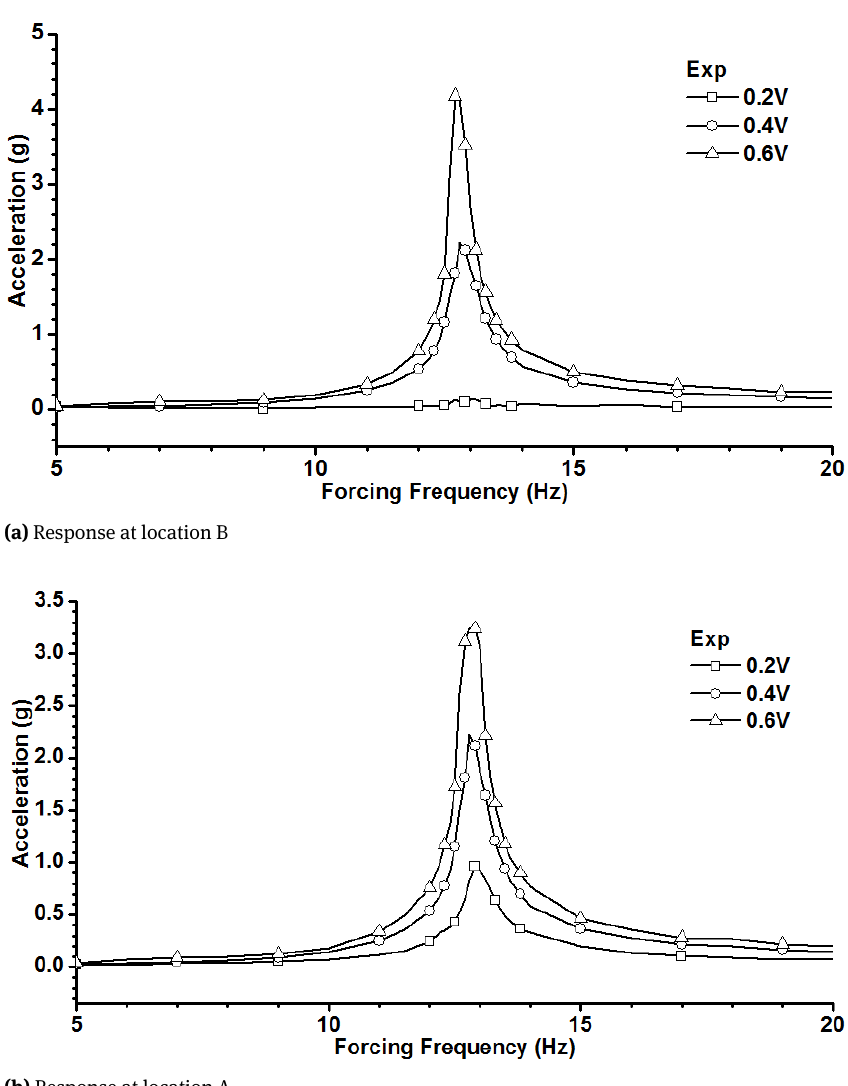
Figure 10: Acceleration versus forcing frequency curves of curved beam (span angle = 130 ∘ ) excited at location A with excitation amplitudes of 0.2, 0.4 and 0.6 Volts: (a) Response at B, (b) Response at